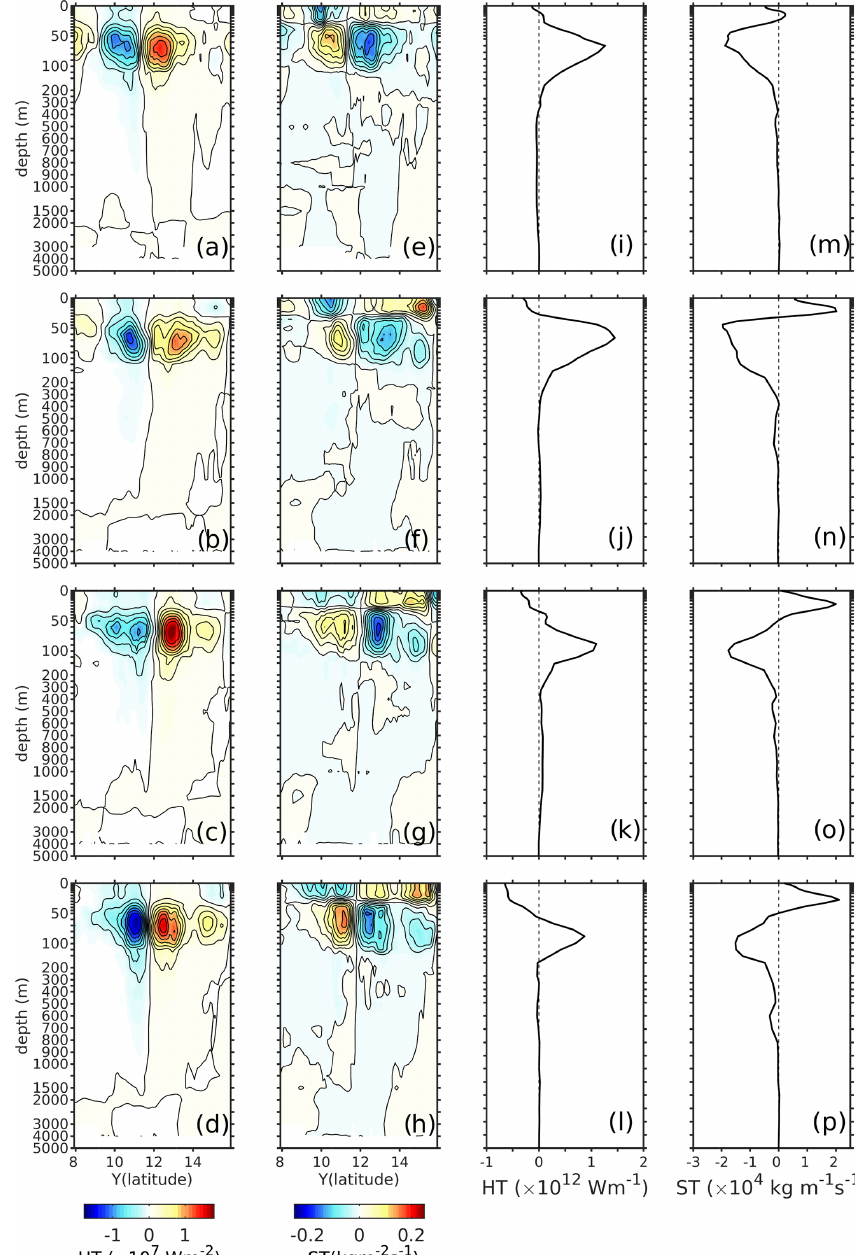
Figure 13. Vertical sections of heat flux (a–d) and salinity flux (e–h) . Vertical profiles of meridionally integrated zonal heat transport (i–l) and vertical profile of meridionally integrated zonal salt transport (m–p) . Each row from top to bottom shows the transects on 3 April, 27 April, 11 May, and 16 May 2019,